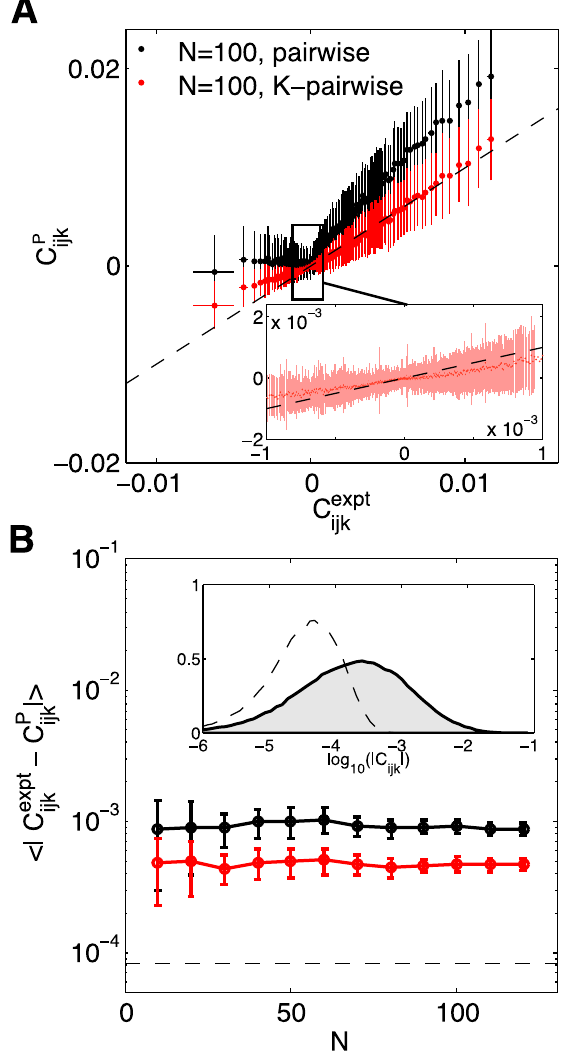
Figure 7. Predicted vs real connected three–point correlations, C ijk from Eq (21). ( A ) Measured C ijk (x-axis) vs predicted by the model (y-axis), shown for an example 100 neuron subnetwork. The , 1.6 6 10 5 triplets are binned into 1000 equally populated bins; error bars in x are s.d. across the bin. The corresponding values for the predictions are grouped together, yielding the mean and the s.d. of the prediction (y- axis). Inset shows a zoom-in of the central region, for the K-pairwise model. ( B ) Error in predicted three-point correlation functions as a function of subnetwork size N . Shown are mean absolute deviations of the model prediction from the data, for pairwise (black) and K-pairwise (red) models; error bars are s.d. across 30 subnetworks at each N , and the dashed line shows the mean absolute difference between two halves of the experiment. Inset shows the distribution of three–point correlations (grey filled region) and the distribution of differences between two halves of the experiment (dashed line); note the logarithmic